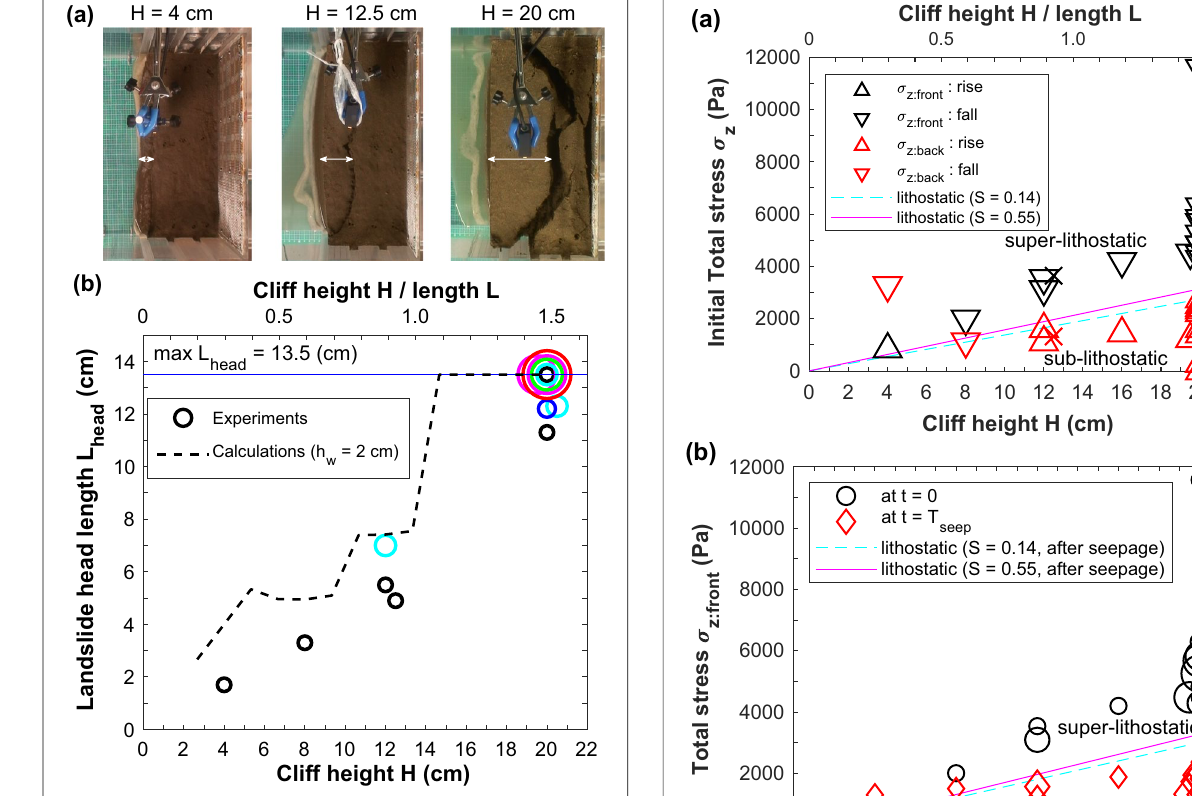
Fig. 8 Cliff height H dependence of the landslide head length L head . a Top views after the first slide of the H = 4,12.5,20 cm cliffs (runs 17, 9, and 13, respectively) with L = 13.5 cm and h w ≃ 2 cm. White arrows indicate the L head . b L head of the first slide versus H (and H / L ), of a total of 14 runs. The size of (cid:31) corresponds to the h w in the range of Fig. 9 a Initial ( t ≃ 0 s) total stress σ z versus cliff height H (and H / L ) ≃ 2 cm (smallest (cid:31) in black) to h = 15 cm (largest (cid:31) in red). A h w w of runs 1–17 in Table 2 ( L = 13.5 cm). σ z : front and σ z : back indicate the black broken line is the L head calculated from the stability analysis for σ z measured near the cliff toe and the back gate, respectively (see = 2 cm. The calculated L h H = 20 cm cliff depends little w head of an Fig. 2b for these locations). (cid:31) ( (cid:31) ) indicates the runs in which the on the h w (see text in Sect. 6.3) rise (fall) in σ z occurred with seepage. × indicates run 9 (see Table 2 legend). A broken (solid) line indicates the lithostatic σ 0 [Eq. (5)] calculated for φ = 0.51 and S = 0.14 (0.55), which is the minimum σ σ ′ (maximum) S in Table 2, and separates the super-lithostatic ( σ z > σ 0 ) overwhelms the rise in z : front indicates that the fall in case above and sub-lithostatic ( σ z < σ 0 ) case below. b σ z : front at u . A possible mechanism for this observation will be dis- ♦ ) versus H . The marker sizes correspond t = 0 s ( (cid:31) ) and at t = T seep ( cussed in Sect. 6.1. to the h w . The lithostatic ˜ σ 0 after seepage [Eq. (6)] was calculated assuming a parabolic phreatic surface with h w = 2 cm. The ˜ σ 0 increases by only a little ( ≤ 6%) for h w = 15 Here we show how the 2 characteristic time scales, T seep and T slide , which define the onset of stages II and III, respectively, depend on the h w and H . Figure 10a shows (cid:31) z the vertical displacement versus time for different h w ≃ 20 values at the same H cm, including the 2 runs with- (cid:31) z out a slide. The slow initial growth of corresponds to (cid:31) the compaction of the cliff prior to the slide. indicates (cid:31) z the at the T slide , which was defined from the thresh- = 0.1 (cid:31) old velocity v 0 mm/s as indicated by in Fig. 10b. Figure 10b shows the v z of the 9 runs in which a slide was triggered. The figure shows that the v z increases by